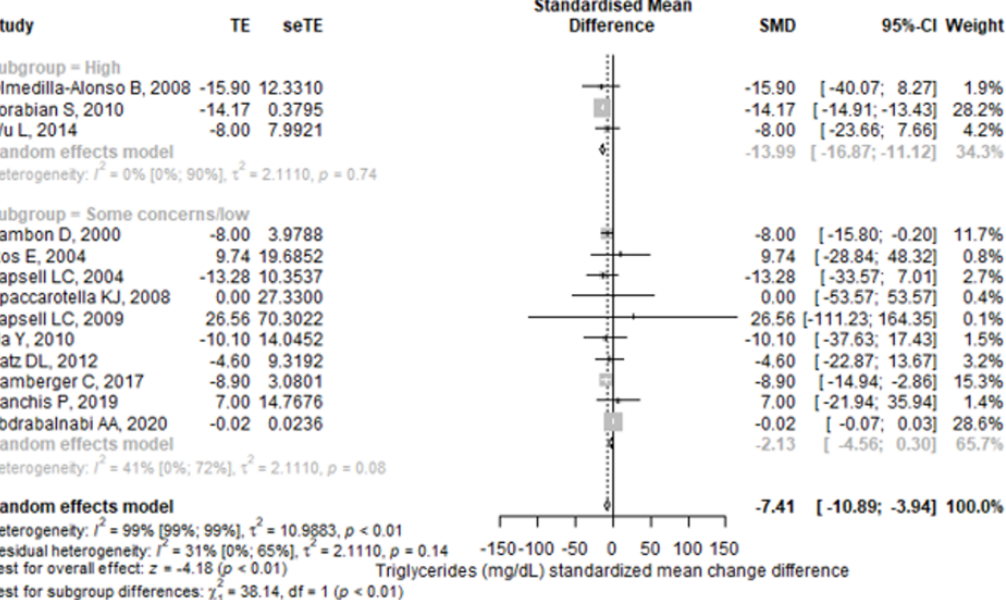
Figure 3. Forest plot for triglycerides (mg/dL) standardized mean change difference compared with subgroup analyses for risk of bias. TE — treatment effect; seTE — the standard error of the treatment effect; SMD — standardized mean difference; CI — confidence interval.